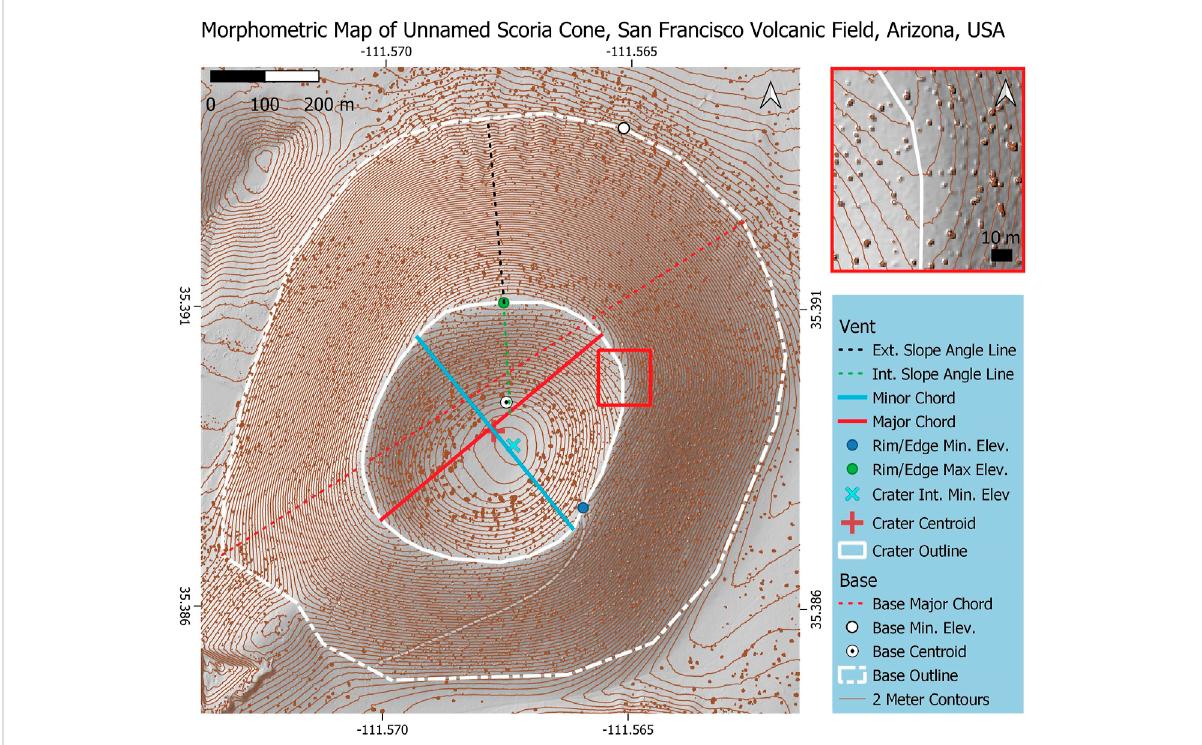
FIGURE 2 Example of morphometry measurements collected for the Small-volume Monogenetic Igneous Landforms and Edi fi ces Statistics (SMILES); shown here is a DEM-derived hillshade Unnamed Scoria Cone, San Francisco Volcanic Field, Arizona, United States. The outline of the landforms is drawn throughbyfollowingthebreak-inslope (redbox; inset topright).The major chord(red)isthelongest distance alongtheoutline (white)ofthe edi fi ce without crossing any portion of the outline; this distinction is important for more complex landforms. The minor chord is 90 ° azimuthal to the major chord and passes through the centroid (red plus). The depth is calculated by averaging the minimum and maximum rim/edge elevation (green dot and blue dot, respectively) and the difference in minimum interior elevation (blue ‘ x ’ ). Interior slope angles are drawn from the maximum rim/edge elevation to the break in slope along the interior wall (green dashed line). Exterior slope angles are drawn from the maximum rim/edge elevationpointtothebaseoutline(whitedashedline).Thebasemajorchord(reddashedline)isthelongestdistanceacrossthebaseandisnotbound by the base centroid (white circle with a black dot). The minimum elevation along the base (white dot) is collected and the location is